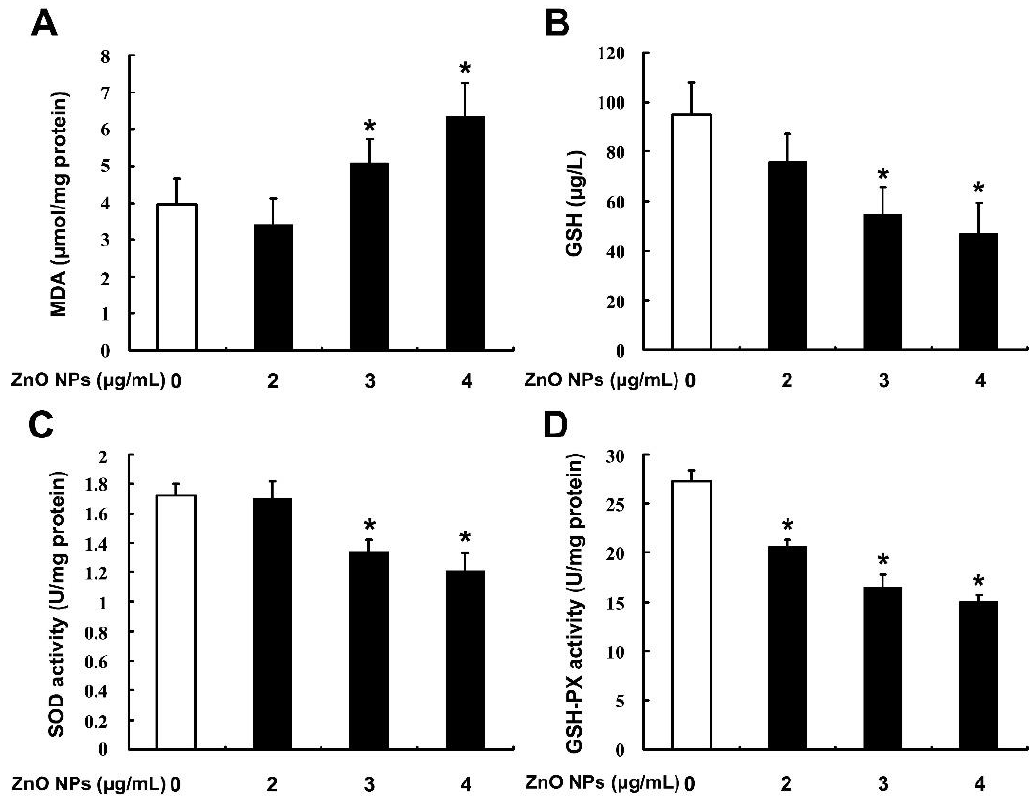
Figure 3. ZnO NPs induce oxidative stress in mouse Leydig TM3 cells. Mouse Leydig TM3 cells were treated with 0–4 µ g / mL ZnO NPs for 24 h; then the contents of MDA ( A ) and GSH ( B ) and the enzyme activities of SOD ( C ) and GSH-PX ( D ) were determined. The experiment was done in triplicate and repeated three times. Data were analyzed by one-way ANOVA. * p < 0.05.